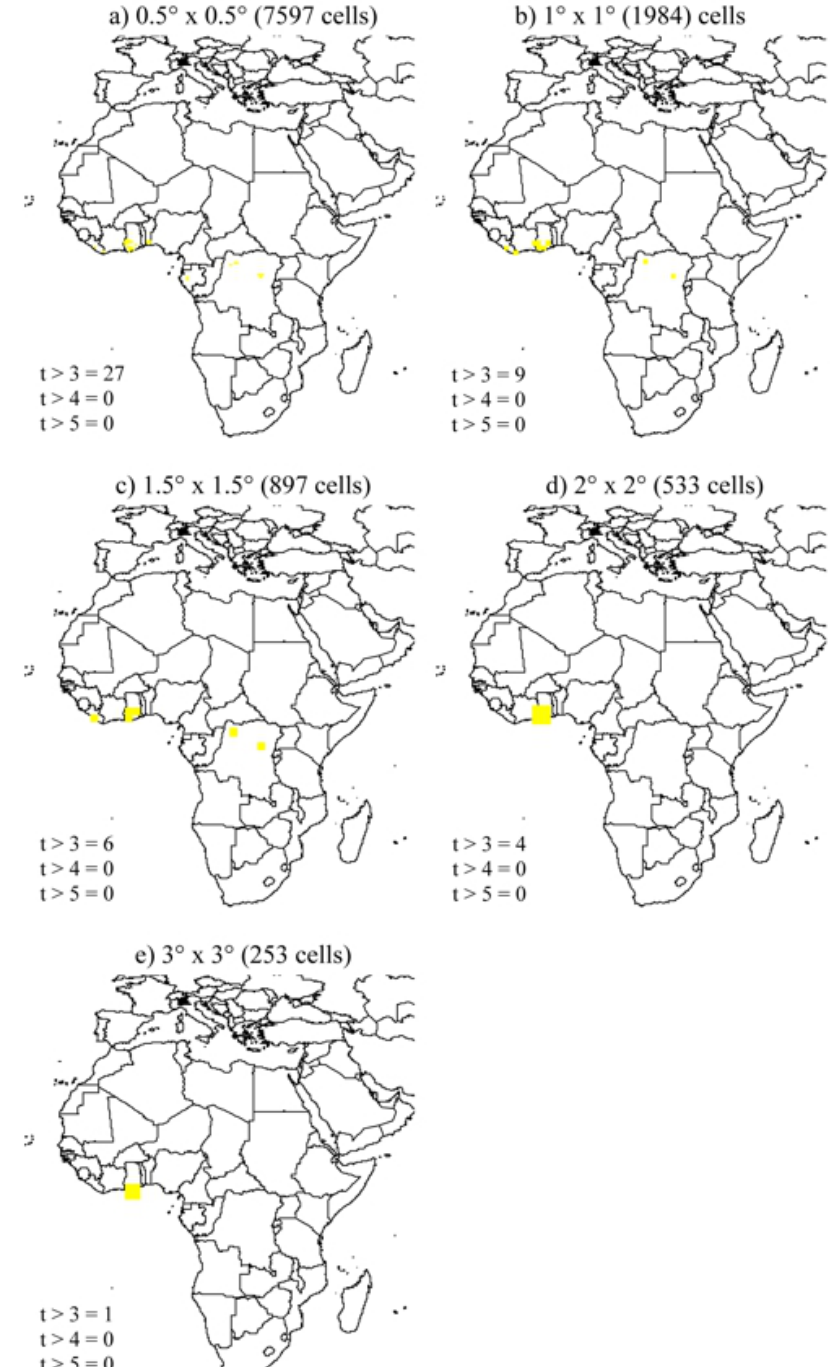
Fig. 3. Areas where NDVI significantly predicted population trends of Common Swift based on